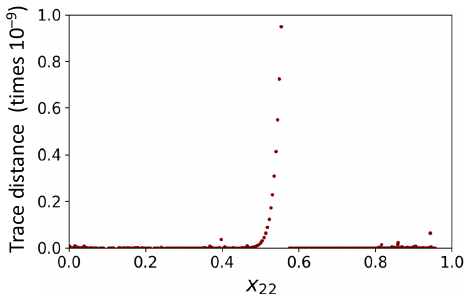
FIG. 5. Trace distance between the maximal entropy-based reconstructed density matrix and the true density matrix as a function of the true mean measurement values of x 22 .